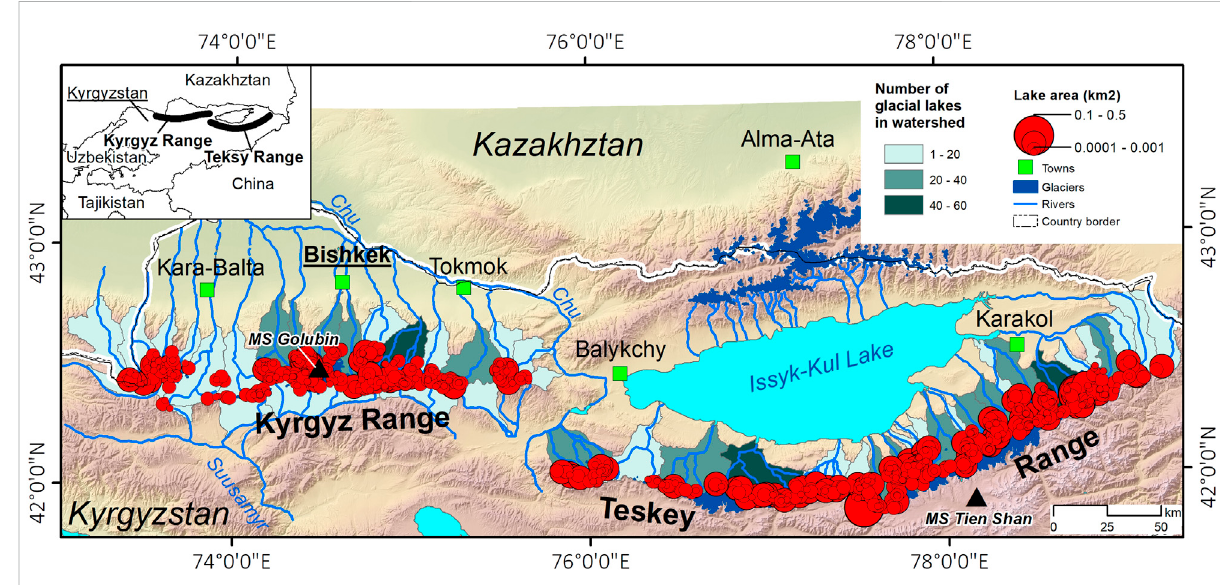
FIGURE 1 The study area and the spatial distribution of glacial lakes in the Kyrgyz and Teskey